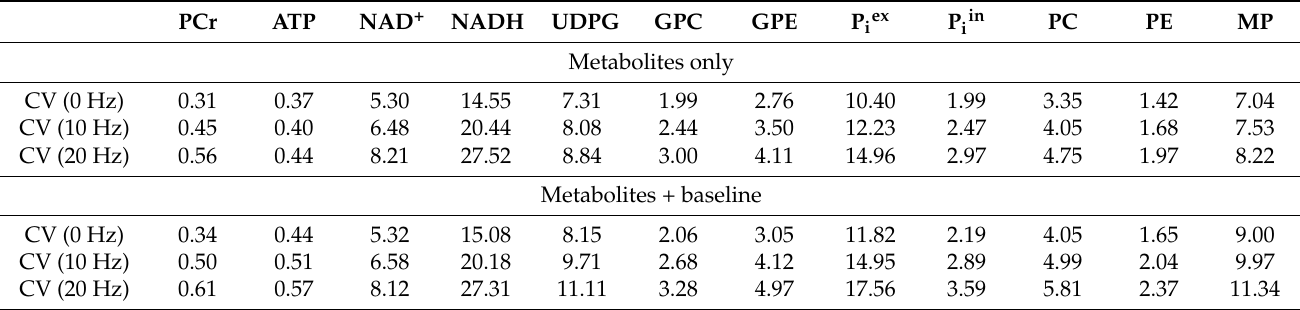
Table 2. Effect of line-broadening on coefficient of variation (CV) at 7